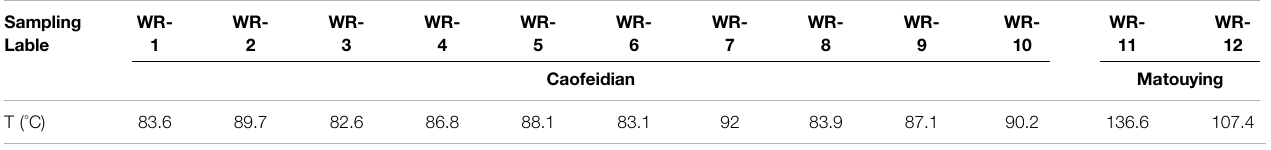
TABLE 3 | Estimated reservoir temperature at the Caofeidian and the Matouying.